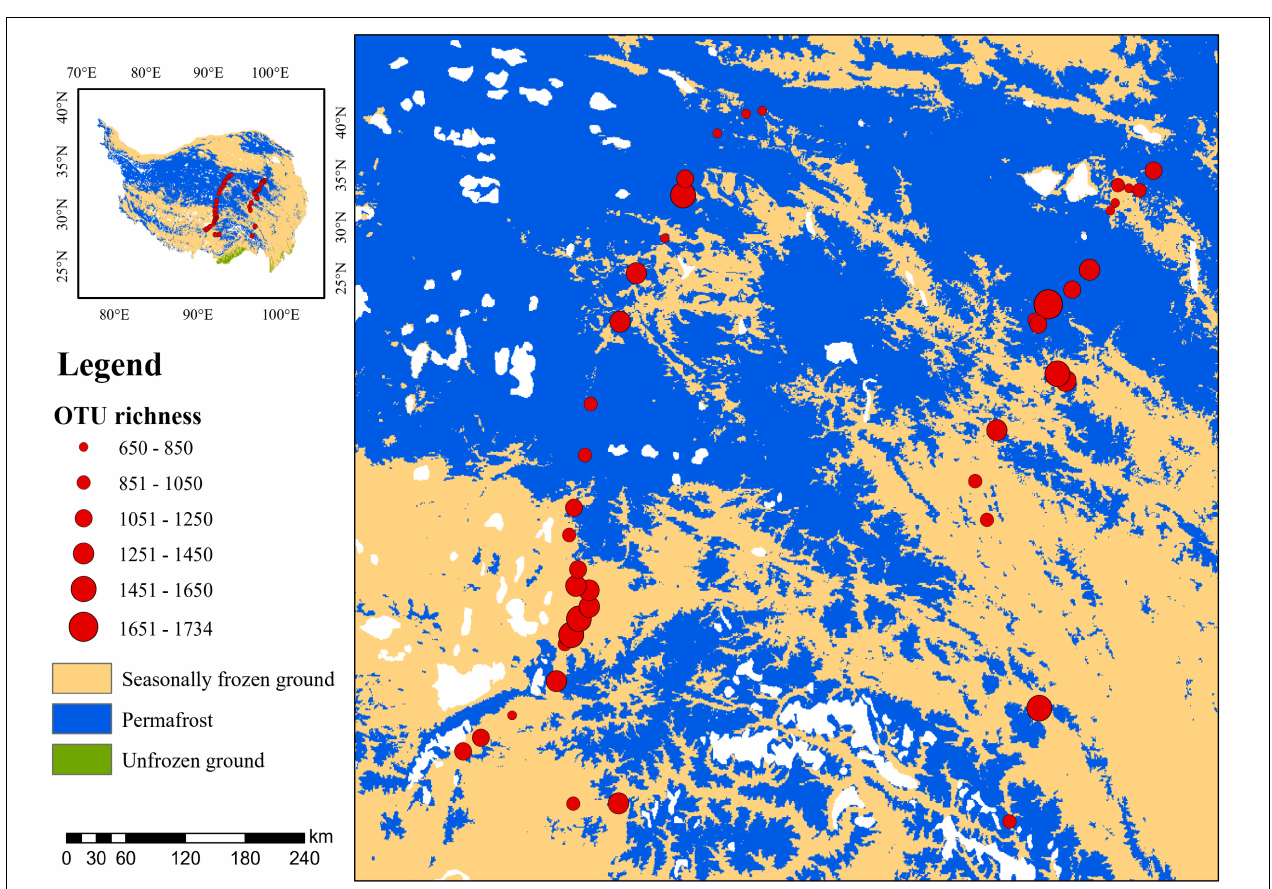
FIGURE 2 | Alpha diversity (OTU richness) of the microbial eukaryotes in sediments of thermokarst lakes across the Qinghai-Tibet